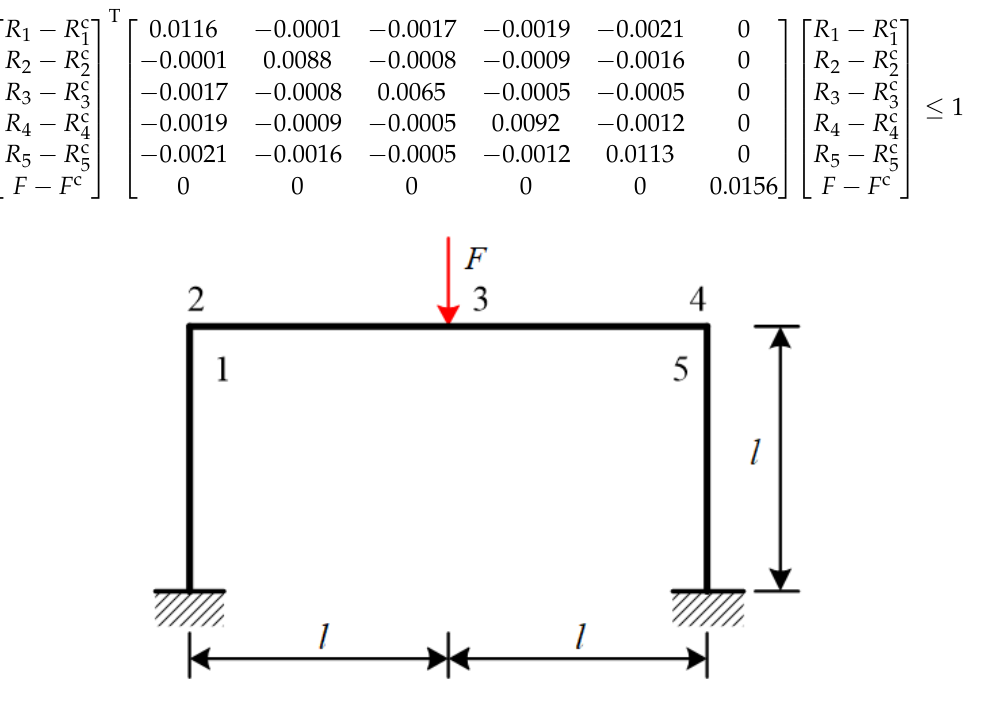
Figure 7. A gate-shaped frame structure.